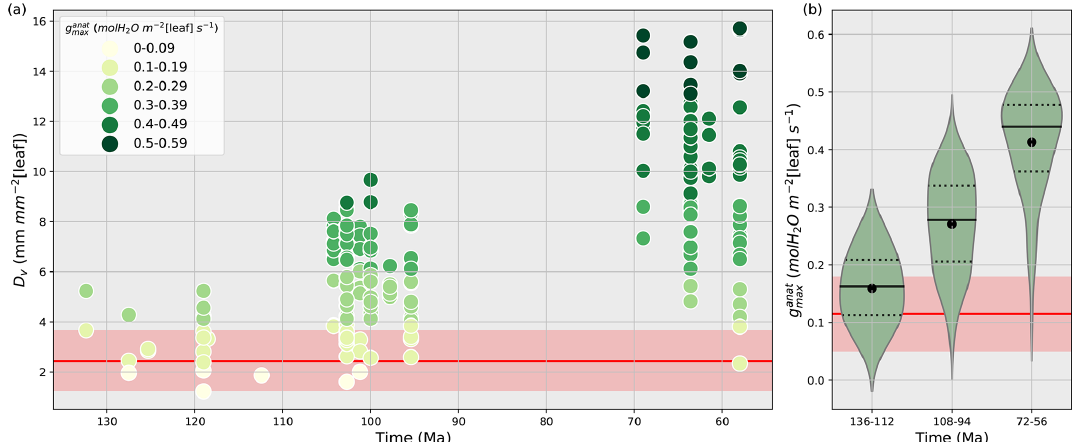
Figure 2. (a) Time evolution of fossil vein densities (mmmm − 2 [leaf], y axis) adapted from Feild et al. (2011a) and the corresponding maximal stomatal conductance to H 2 O (molm − 2 [leaf]s − 1 , filled circles) calculated by the anatomic relationship (Eq. 8) developed by Brodribb et al. (2007) and Brodribb and Feild (2010). (b) Subdivision of maximal stomatal conductance to H 2 O (molm − 2 [leaf]s − 1 ) by time periods. The black solid lines are the angiosperm medians, the black dotted lines are the first and third quartiles, and the black points are the angiosperm mean values for each time period. Red lines and areas show the gymnosperm mean values and the gymnosperm mean ± 1 standard deviation area, respectively, over the